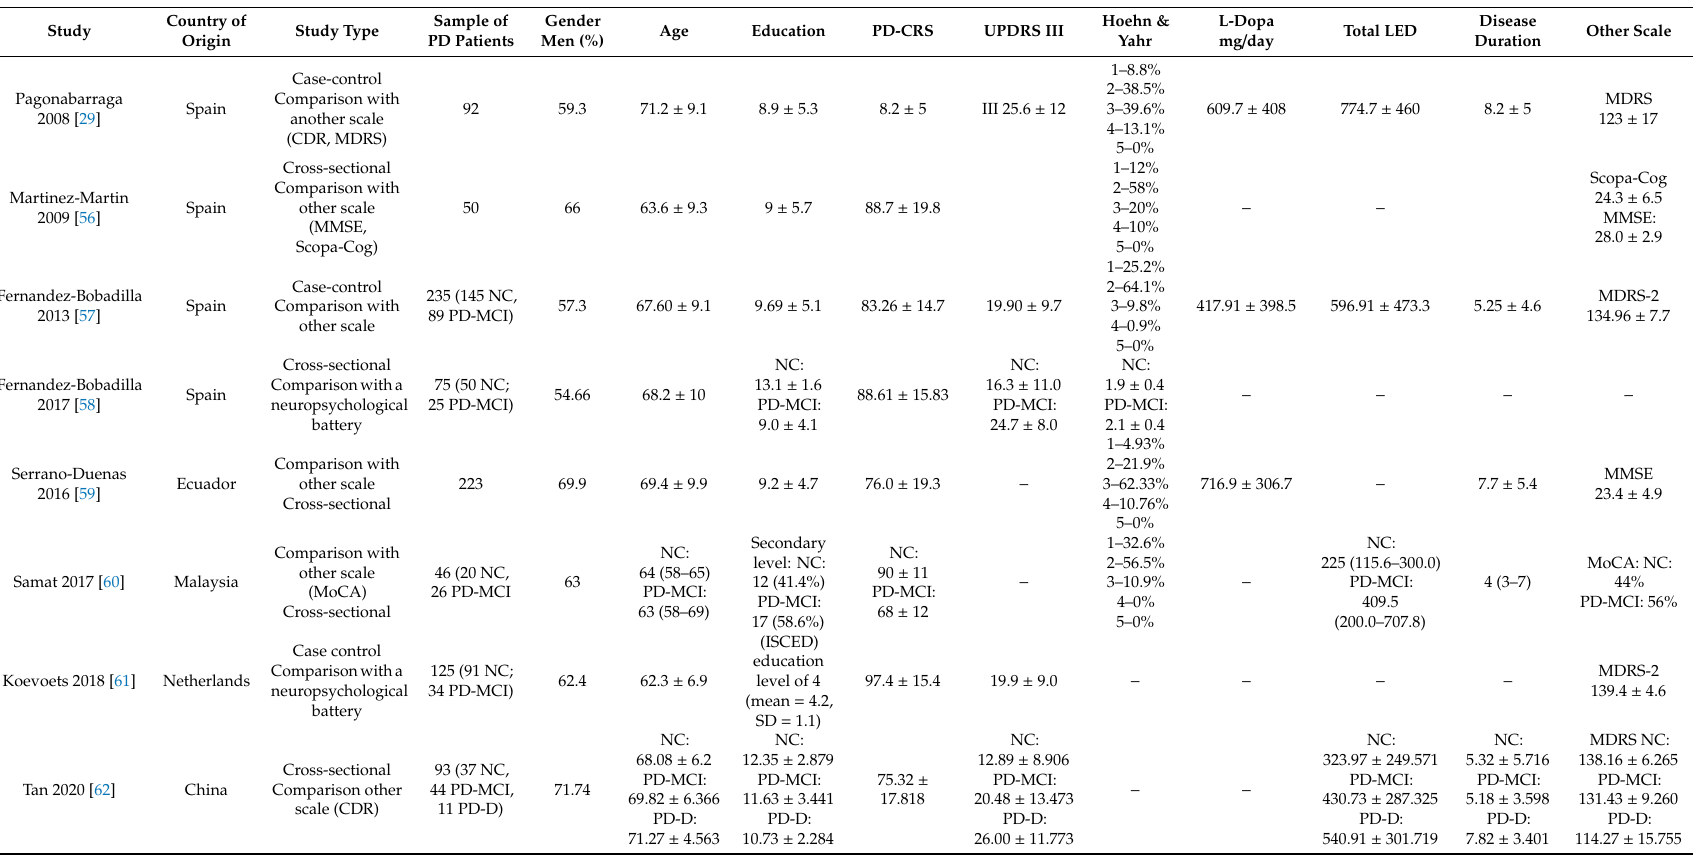
Table 1. Characteristics of included